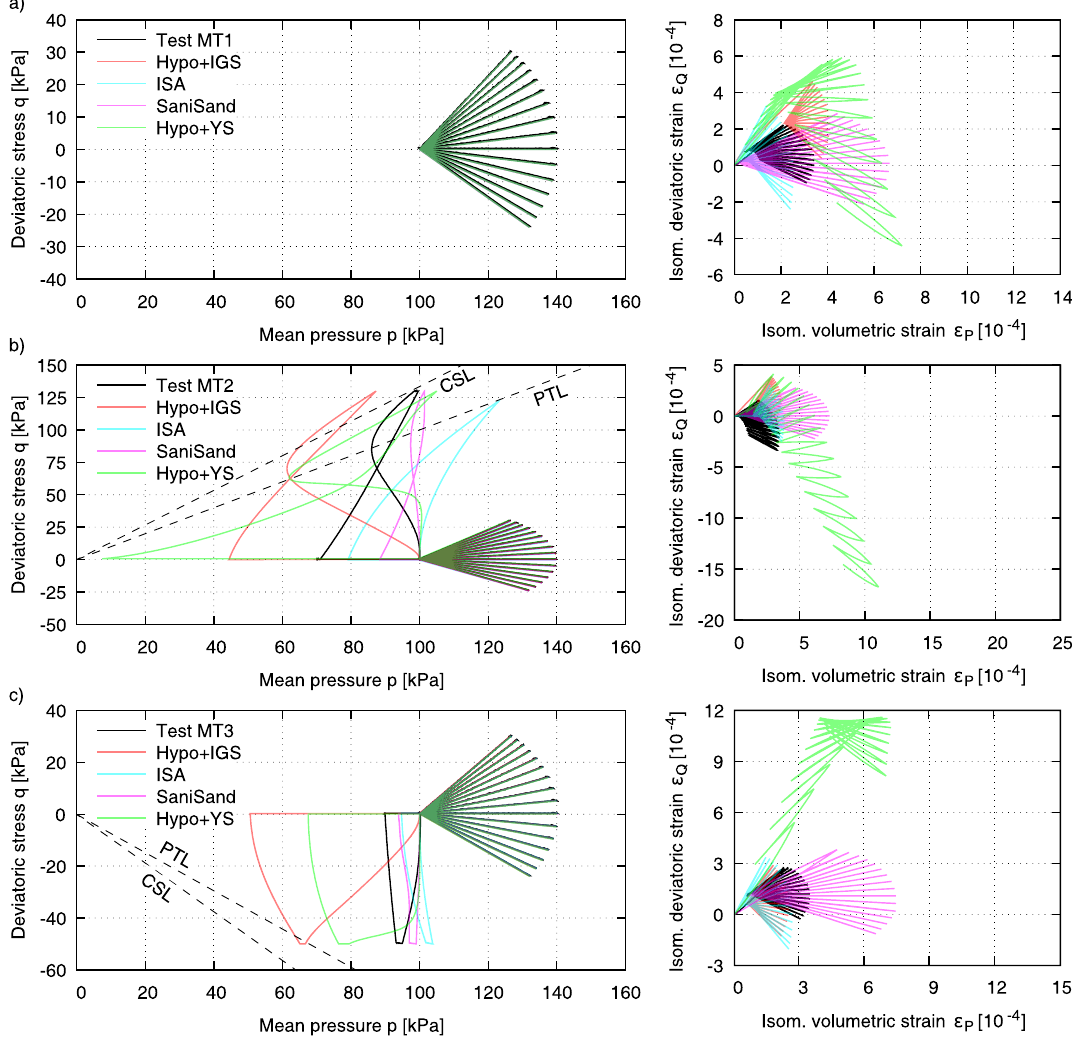
Figure 13. Simulations of tests with moist tamping: MT1, MT2 (large undrained preshearing in triaxial compression) and MT3 (small undrained preshearing in triaxial